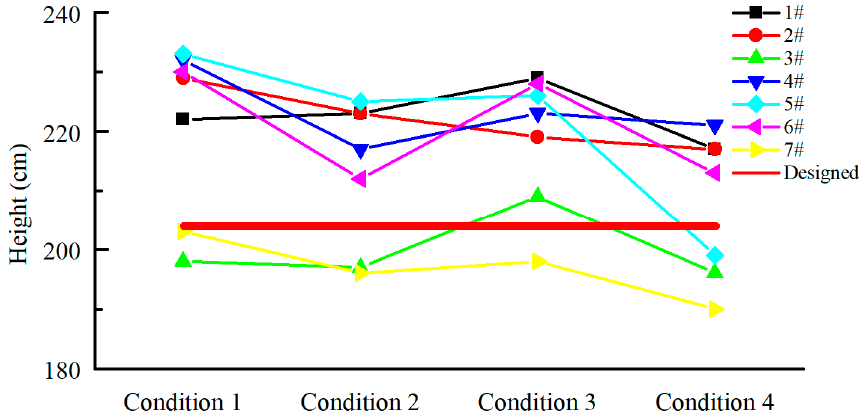
Figure 17. The liquid level height.